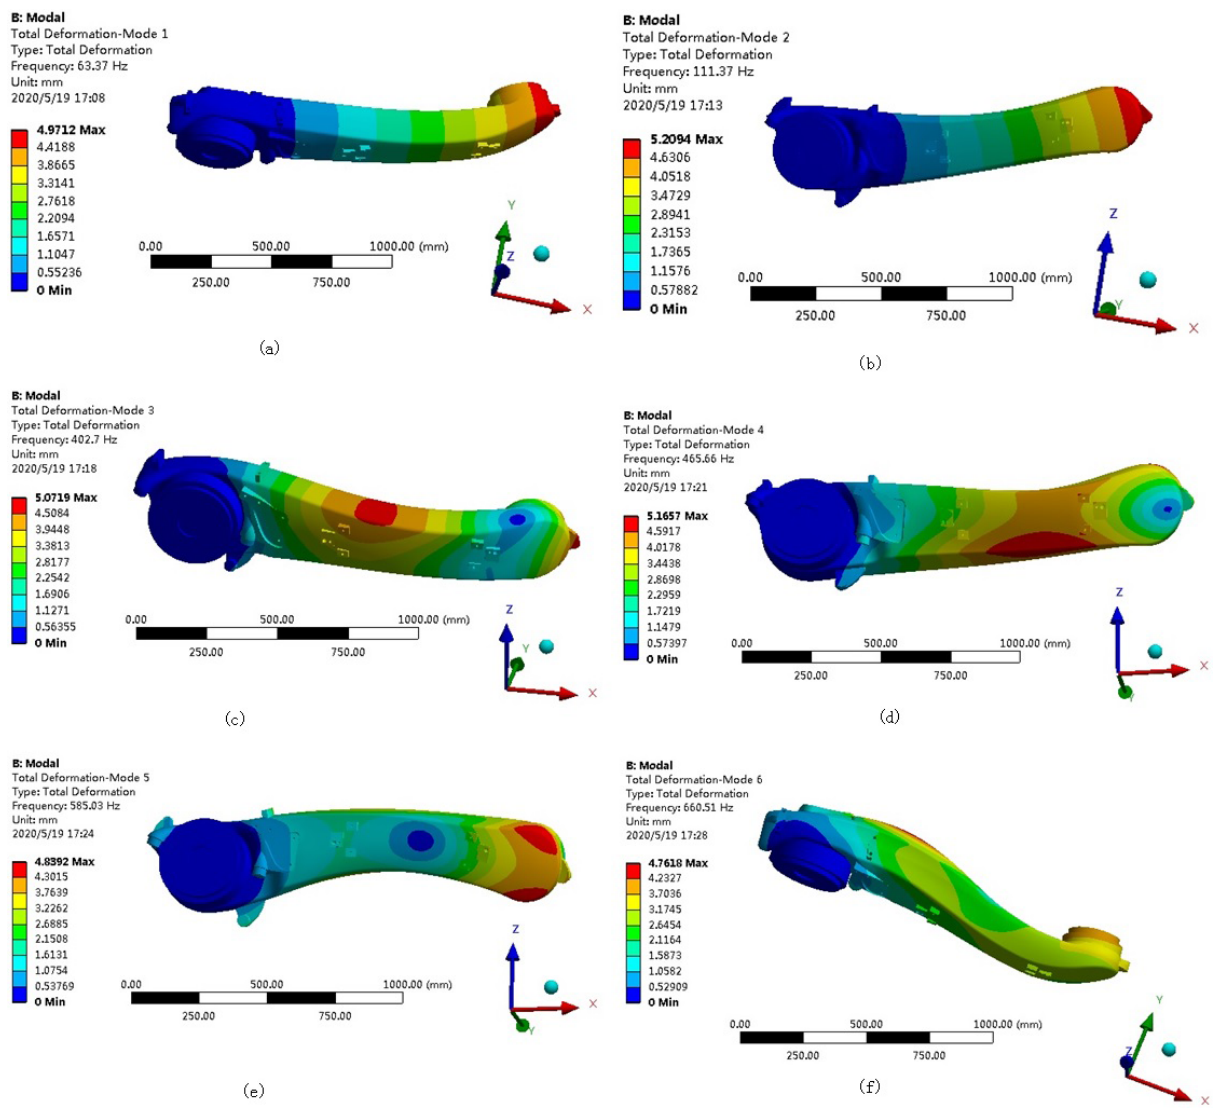
Figure 9. First six-order modes: (a) first-order mode; (b) second-order mode; (c) third-order mode; (d) fourth-order mode; (e) fifth-order mode; (f) sixth-order